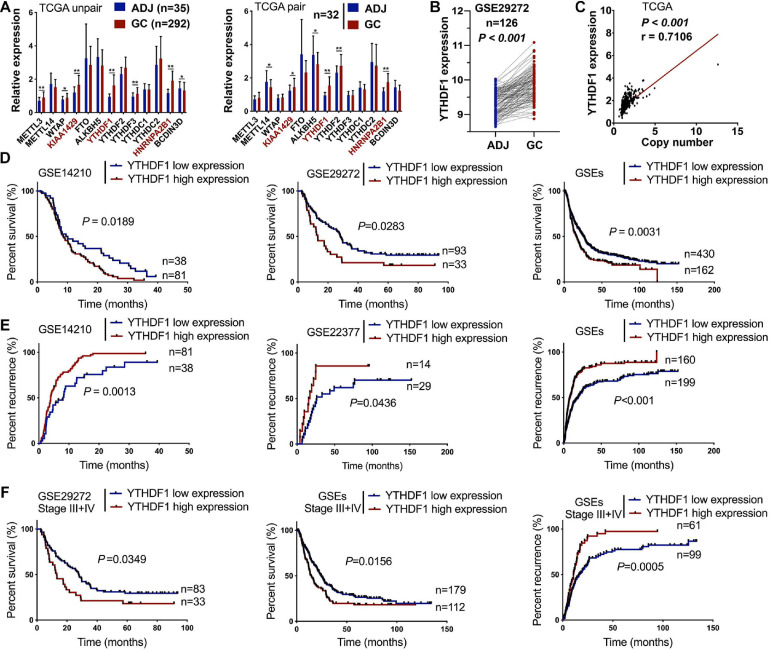
High expression of YTHDF1 predicts a poor prognosis in patients with GC. (A) Gene expression of m6A-related compositions in patients with GC according to TCGA dataset (unpaired or paired). (B) Gene expression of YTHDF1 in patients with GC according to GSE29272 dataset (n = 126). (C) Correlation analysis between gene expression and the copy number status of YTHDF1 in TCGA-GC dataset. (D,E) Kaplan–Meier analysis of GC patients in GSEs dataset for the correlations between YTHDF1 expression and overall survival. as well as tumor recurrence. (F) Kaplan–Meier analysis of GC patients with Stage III and Stage IV in GSEs database. ADJ, adjacent normal; GC, gastric cancer. Data are shown as means ± S.D. *P < 0.05, **P < 0.01.